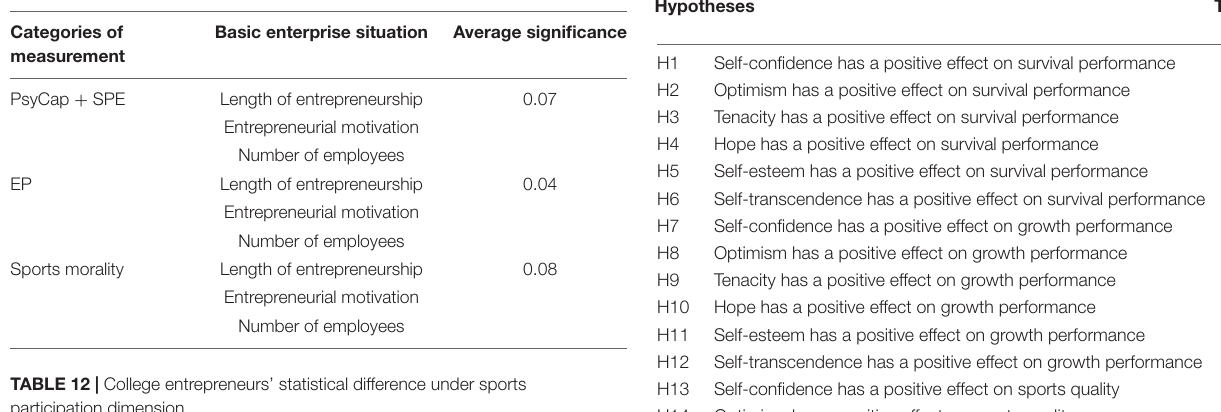
TABLE 11 | College entrepreneurs’ significant difference analysis from the enterprise situation.